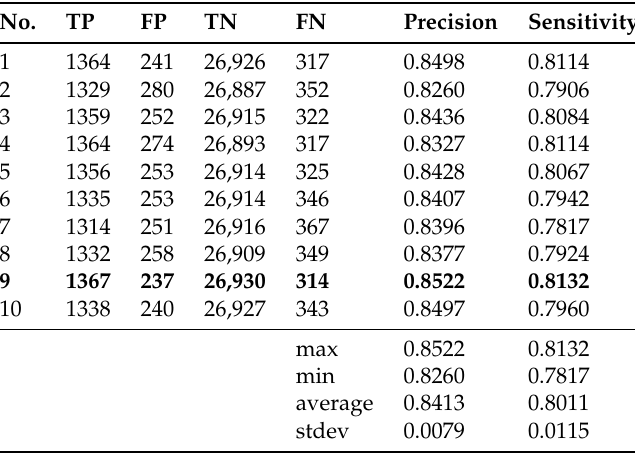
Table 3. Strategy II performance on model test data.